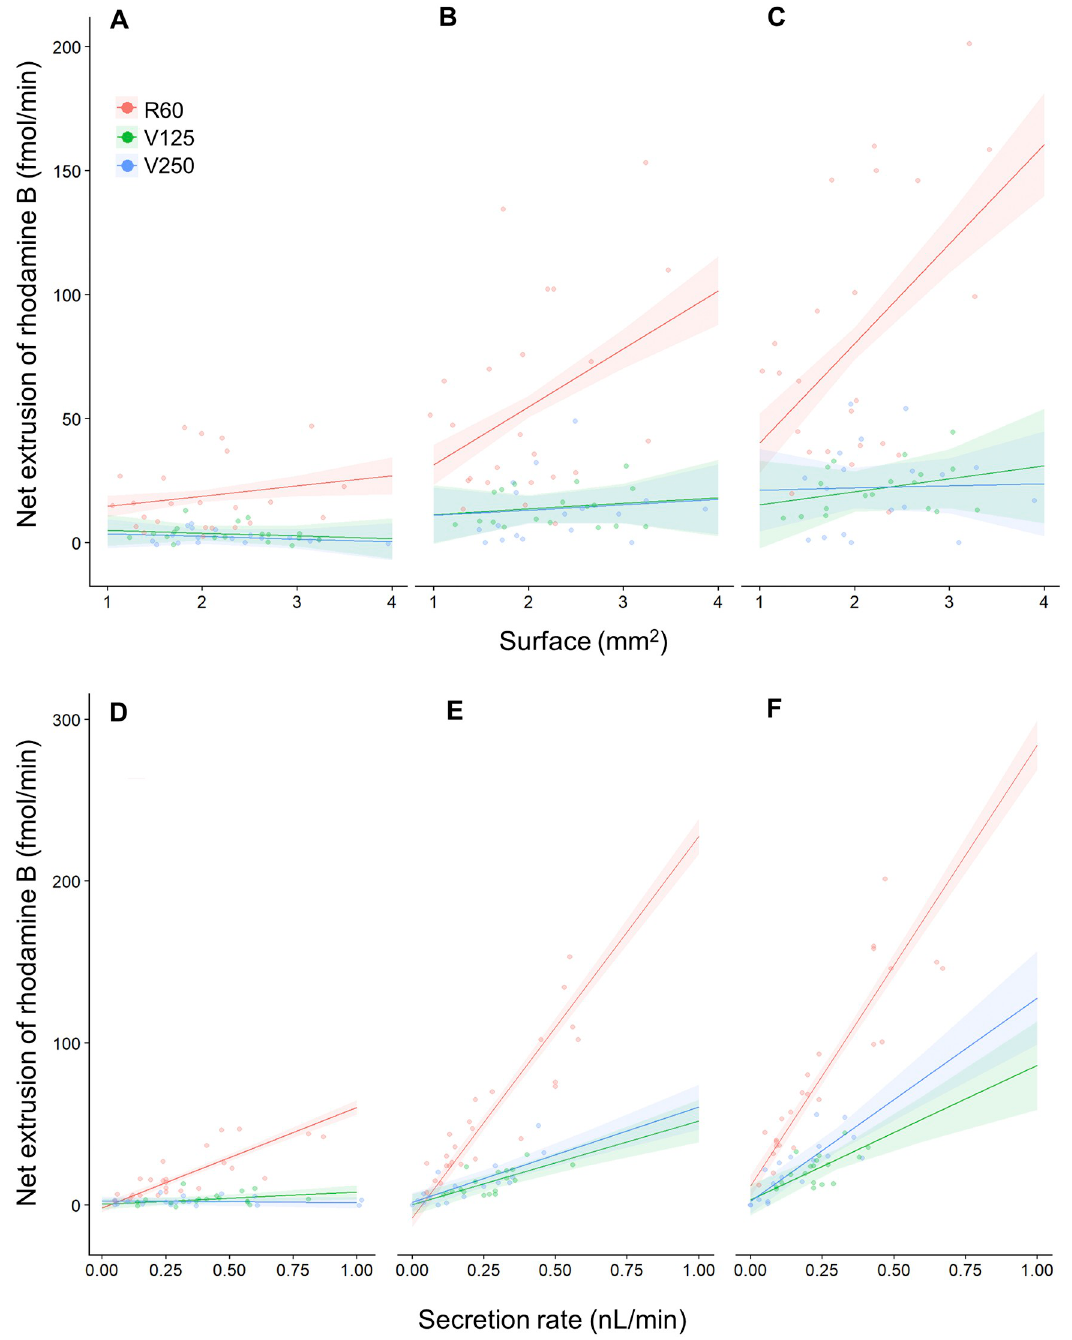
Fig 5. Tubule surface area and the fluid secretion rate positively influences the net extrusion of rhodamine B. ( A ) A plot of the surface area of the tubule exposed to the bath versus the net extrusion of rhodamine B for each of the three treatments after 30 minutes of incubation. ( B ) As in ‘A’ but after 60 minutes. ( C ) As in ‘A’ but after 90 minutes. ( D ) A plot of the fluid secretion rate versus the net extrusion of rhodamine B for each of the three treatments after 30 minutes of incubation. ( E ) As in ‘D’ but after 60 minutes. ( F ) As in ‘D’ but after 90 minutes. Small circles indicate the net extrusion of rhodamine B of individual tubules at a particular time point. Each line with the shaded area around represents the mixed effect model fit with the standard error.